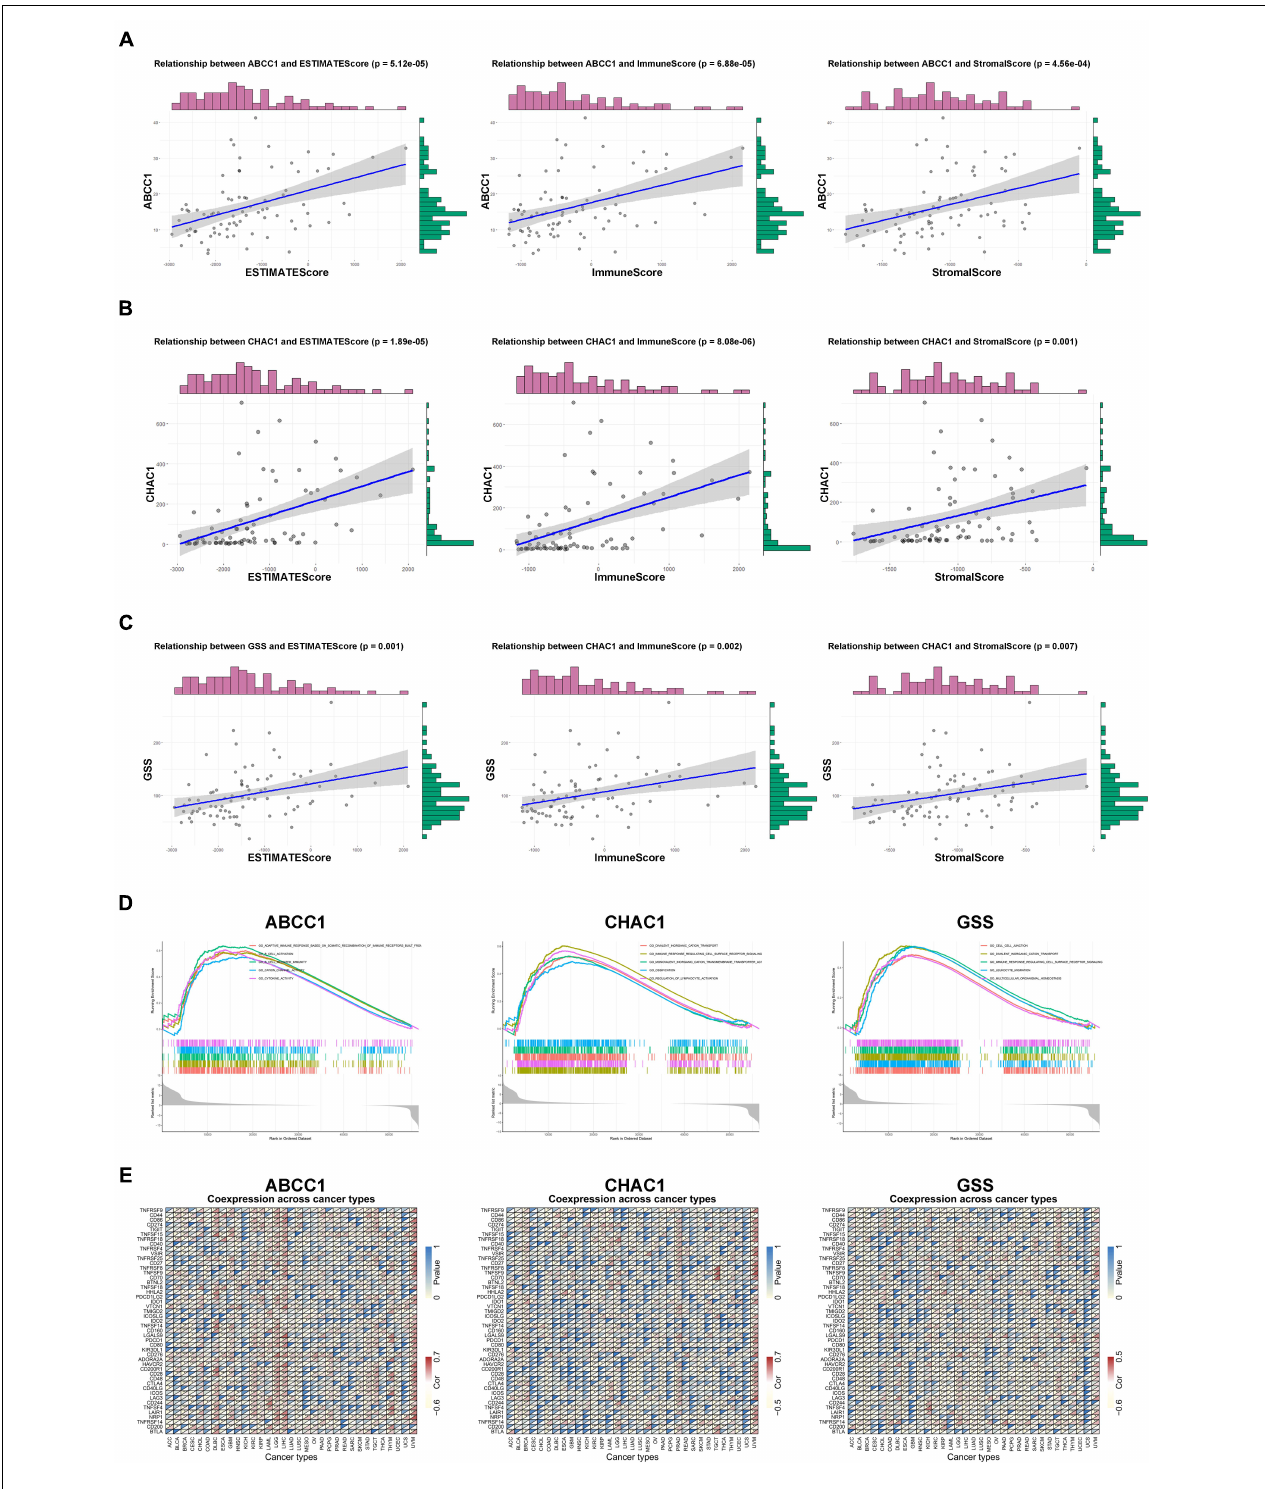
FIGURE 8 | Evaluation of key genes in immune landscape. (A) Relationship between ABCC1 expression and ESTIMATEScore, ImmuneScore, as well as StromalScore. (B) Relationship between CHAC1 expression and ESTIMATEScore, ImmuneScore, as well as StromalScore. (C) Relationship between GSS expression and ESTIMATEScore, ImmuneScore, as well as StromalScore. (D) GSEA analysis of ABCC1, CHAC1, and GSS in UVM. (E) Correlation among ABCC1, CHAC1, and GSS expression and immune-related mRNAs.